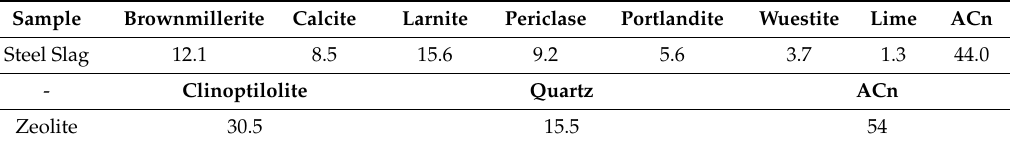
Table 2. Mineral content of raw materials (wt.%) .